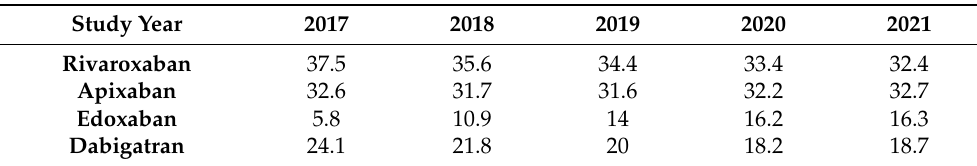
Total number of serious ADR, ICH ADR, and GI ADR for each molecule and for each study year are also shown. ADR: adverse drug reaction; GI: gastrointestinal; ICH: intracranial hemorrhage. Table 2. Usage rate (%) for each DOAC during the study